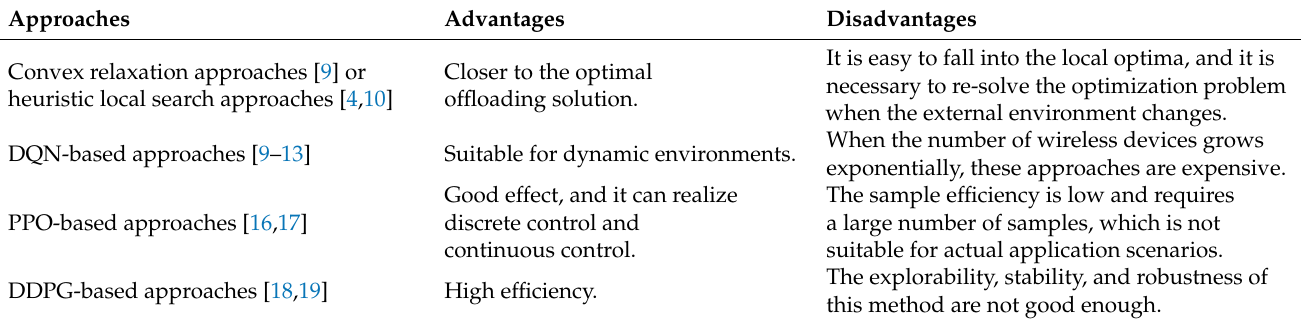
Table 1. Comparison of